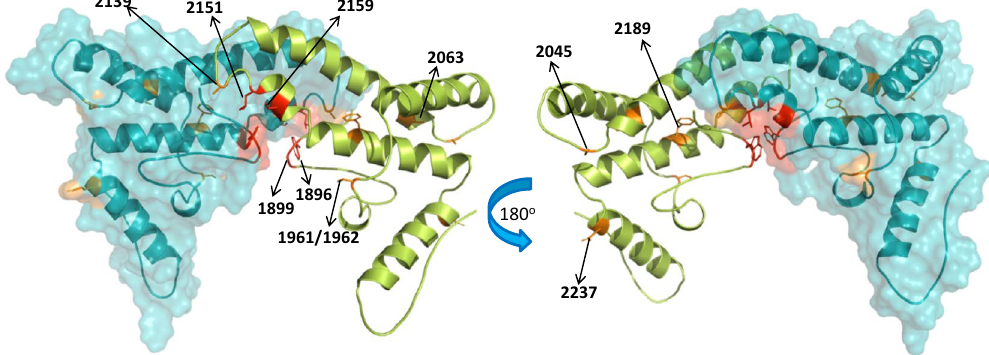
Figure 3. HBeAg dimer structure. Two views of the HBeAg dimer structure (PDB: 3V6Z) with one monomer in teal surface representation and the other in green cartoon representation. Shown is a subset of HBV variants labeled by HBV genome position. The four HBeAg residues harboring 1896, 1899, 2151, and 2159 variants are at the dimer interface and are colored in red; six HBeAg residues harboring 1961/1962, 2045, 2063, 2139, 2189, and 2237 variants are within intra-dimer interaction region and are colored in